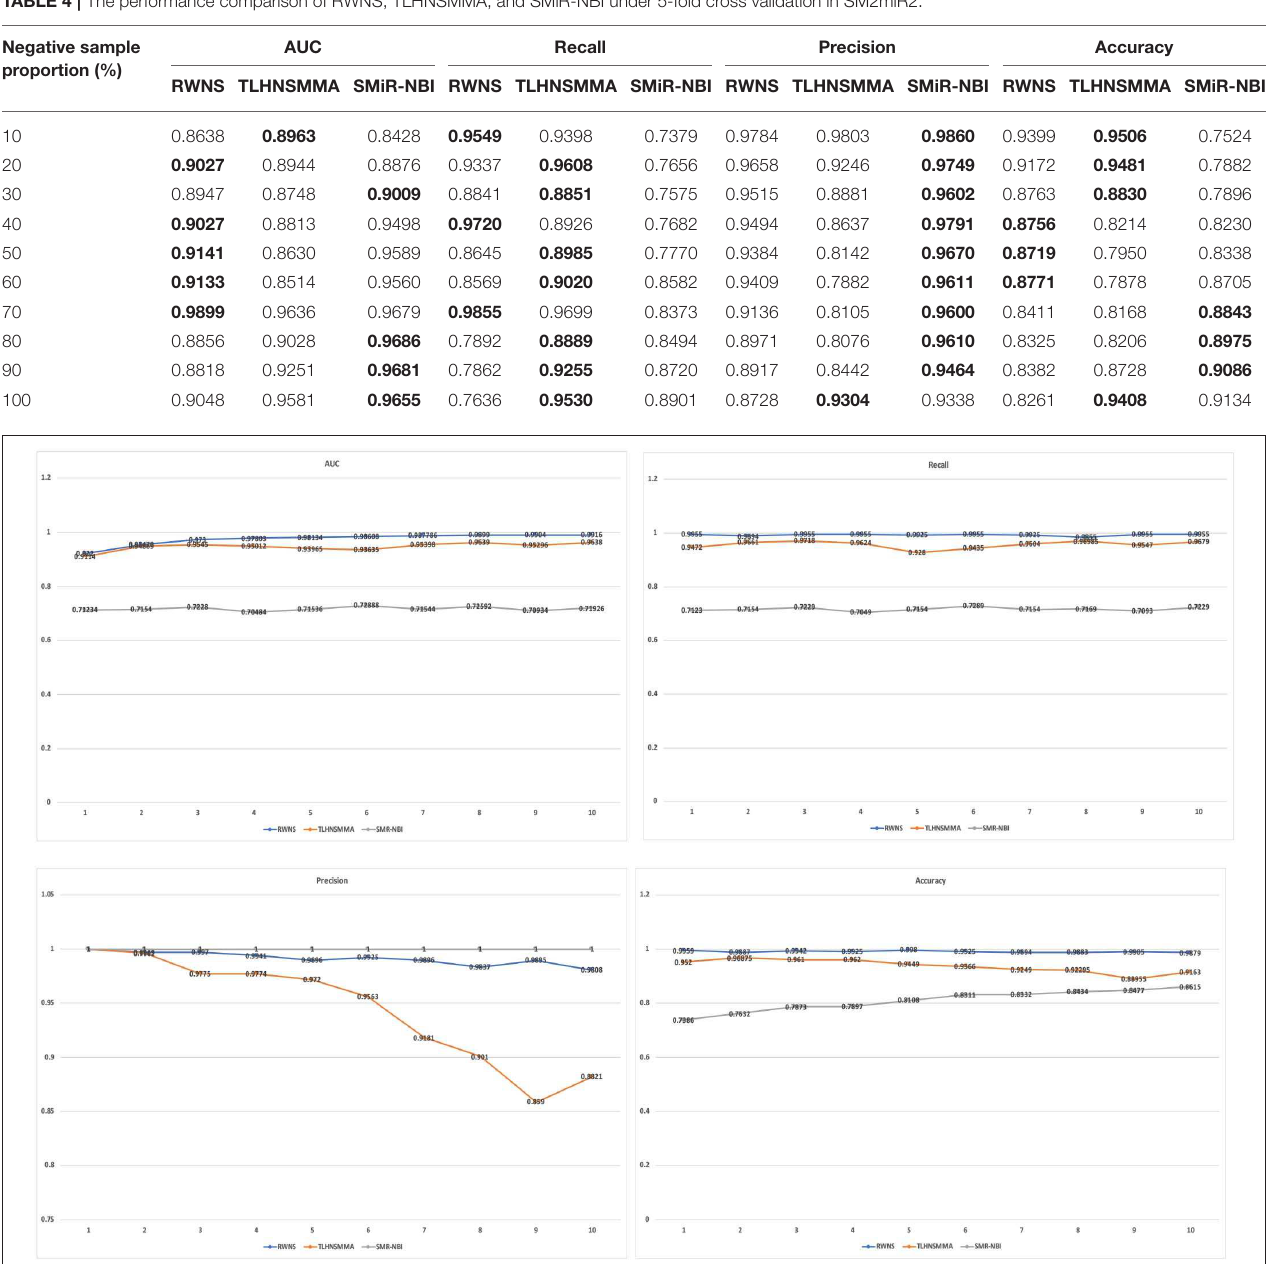
TABLE 4 | The performance comparison of RWNS, TLHNSMMA, and SMiR-NBI under 5-fold cross validation in SM2miR2. Negative sample proportion (%)